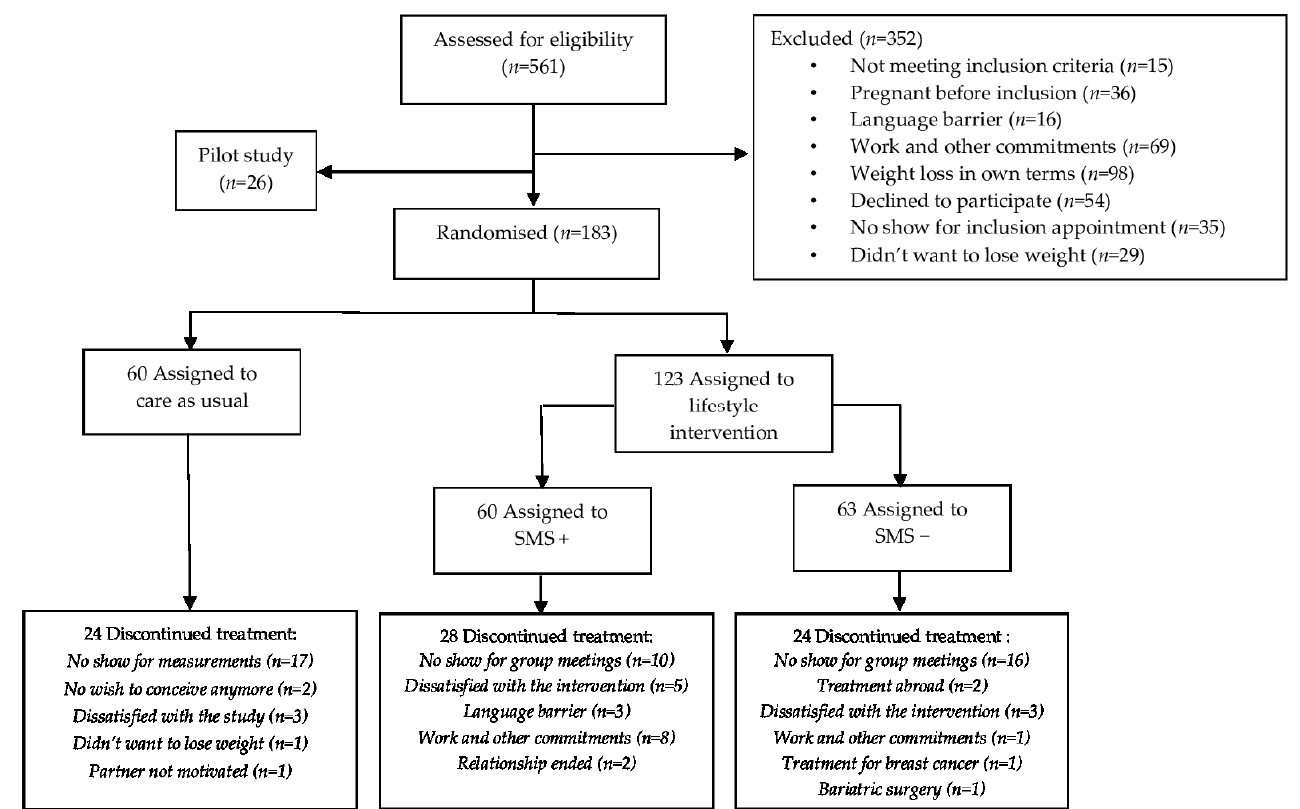
Figure 1. CONSORT Figure 1. CONSORT flowchart.